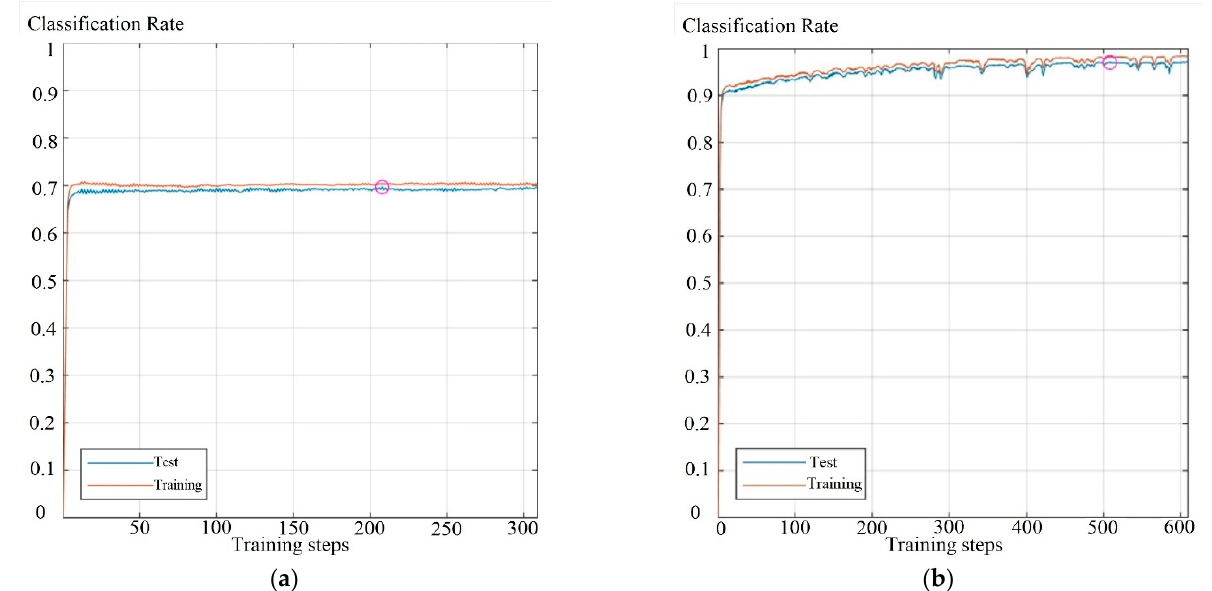
Figure 11. Classification results obtained for a network branch with five cable sections: ( a ) Global classification rate obtained during the test and training phase by using a dataset with four frequencies; ( b ) Global classification rate obtained during the test and training phase by applying the principal component analysis to a dataset with 100 frequencies.